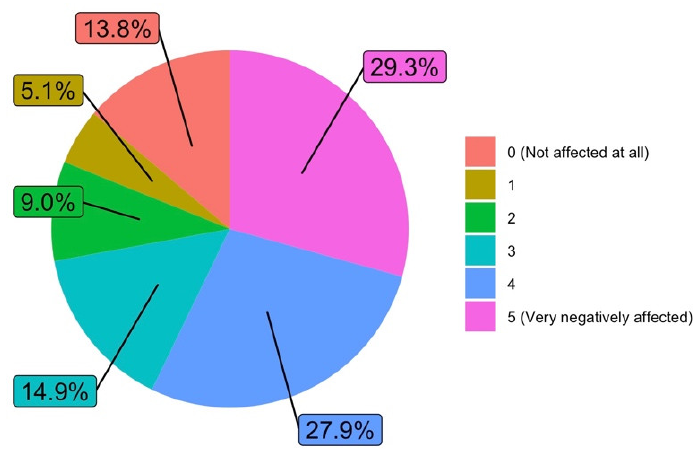
Figure 10. Effects on research due to virtual teaching dedication (answers to Q11).